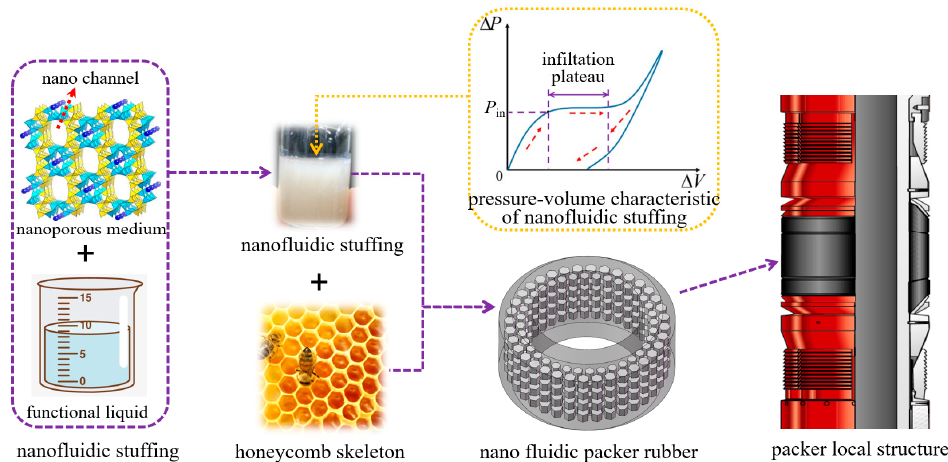
Figure 1. Structure diagram of nanofluidic packer rubber.